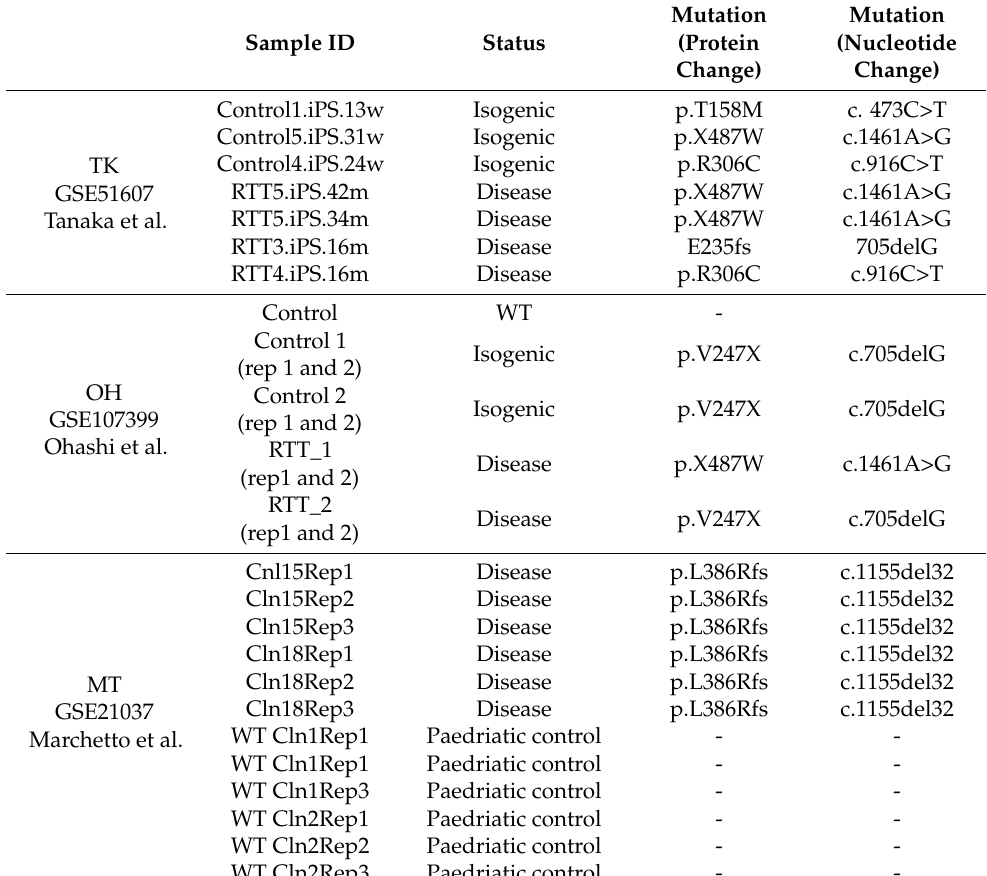
Table 1. Summary table of studies used in the present study, including sample ID, status and mutation (protein change and nucleotide